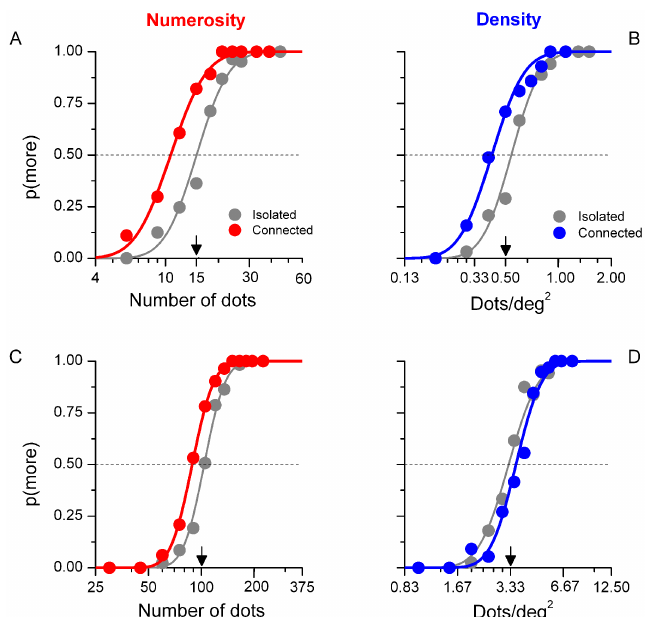
Figure 2. Aggregate psychometric functions for low and high numerosities: A and B 15 dots (density 0.5 dots/deg 2 , C and D 100 dots (density 3.3 dots/deg 2 ). A and C show judgements of numerosity, B and D density (in separate sessions). All graphs plot the proportion of times the subject reported the probe to be more numerous (or more dense) than the reference, as a function of probe number. Coloured lines refer to the connected condition (reference containing 40% of connected dots), greys lines to the isolated dots condition (baseline). Leftward shifts of coloured curves imply underestimation of the connected-dot